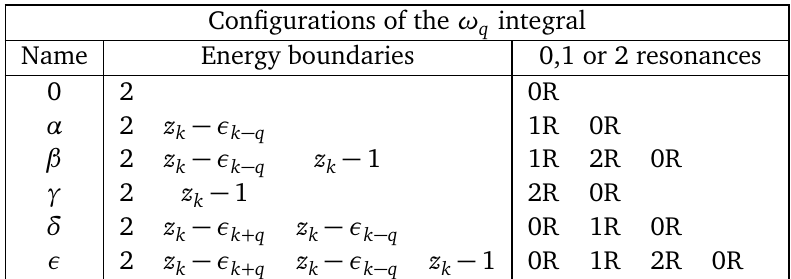
(at fixed k , z and q q k − ε < ω < z − 1 k k − q q k